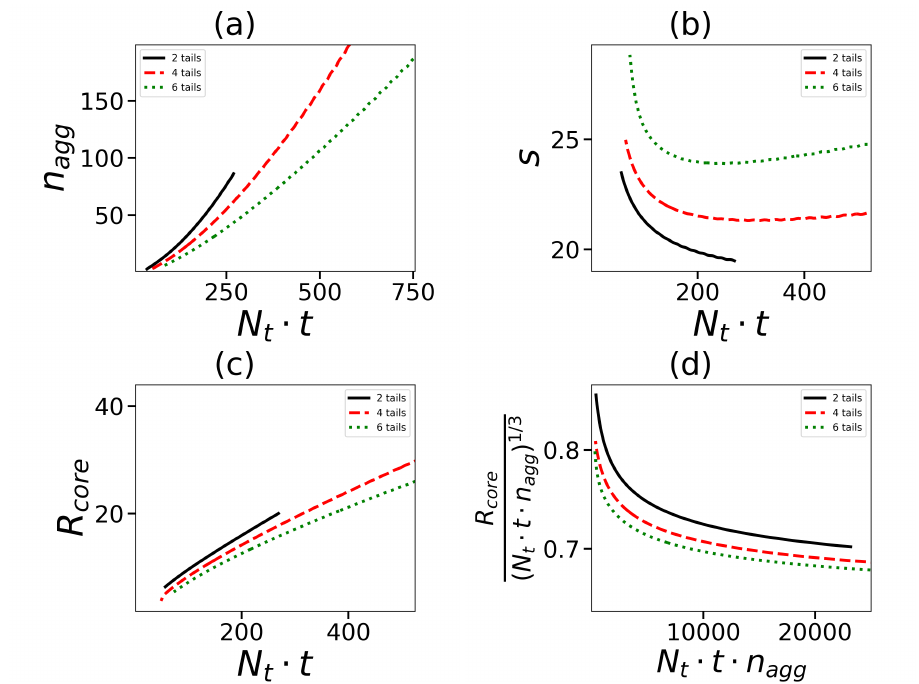
Figure 6. ( a ) The aggregation numbers n agg , ( b ) the surface area s per one dendron of a core, ( c ) the size of micelle core R core as a function of the overall number of units in tails N t · t . ( d ) R core / ( N t · t · n agg ) 1/3 as a function of the overall number of units in core N t · t · n agg . All cases correspond to the same generation number G = 4.